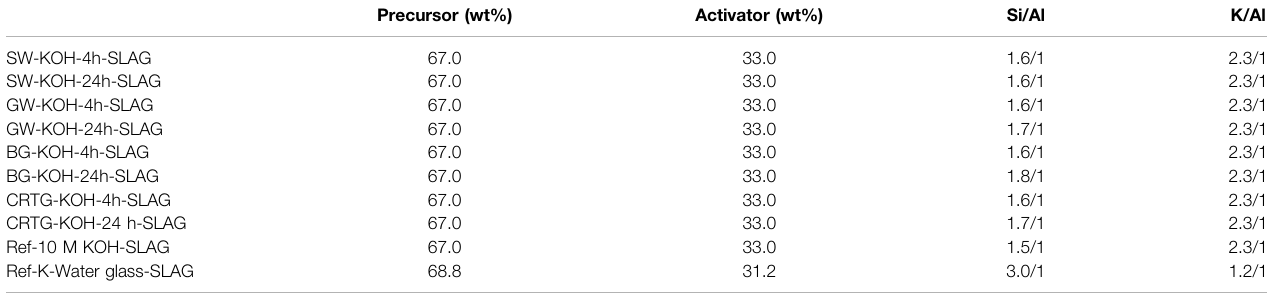
TABLE 1 | The paste formulations, presented in terms of the mass percentages of the precursor and activator (wt%), and the nominal Si/Al and K/Al molar